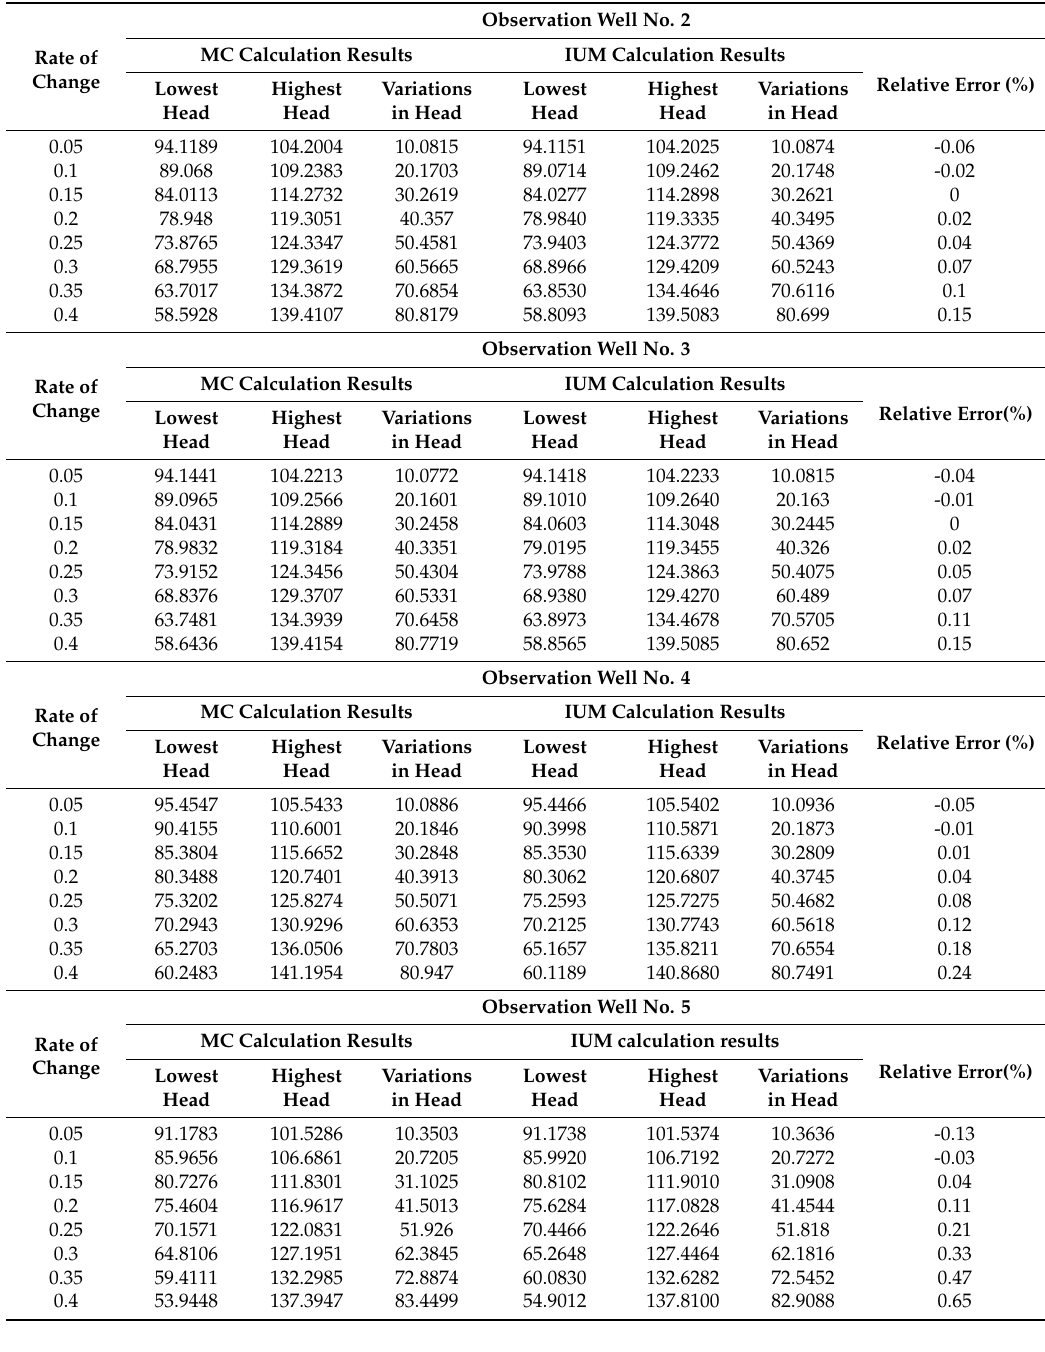
Table 6. Calculation results table for Scenario Three (unit: m).